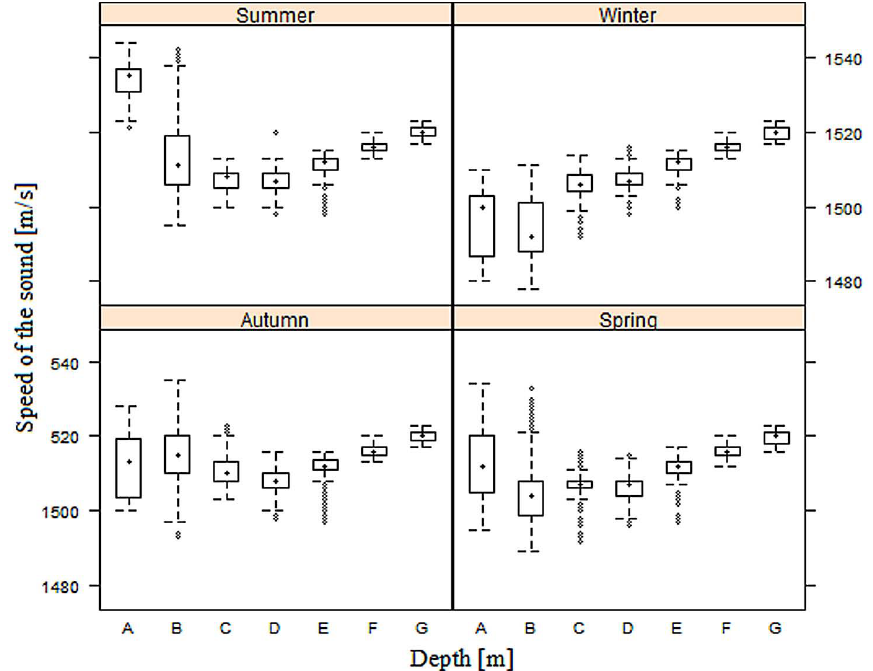
Fig. 2. – Seasonal variations of the calculated Speed of the sound [m s –1 ] from different depth strata (A: 0-10 m; B: 11-50 m; C: 51-100 m; D: 101-200 m; E: 201-500 m; F: 501-800 m; G: 801-1000 m). Strata are defined following the MEDITS sampling strategy (Bertrand et al.